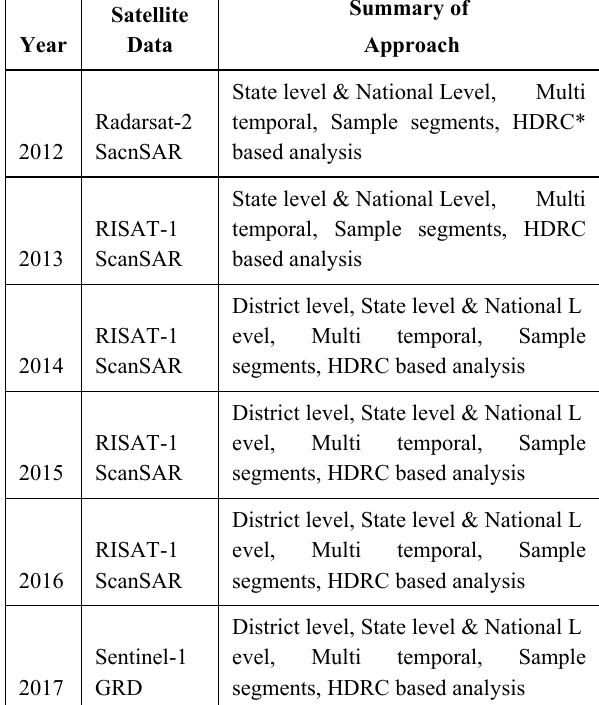
Table 2. Year wise Approach followed for paddy area estimation.